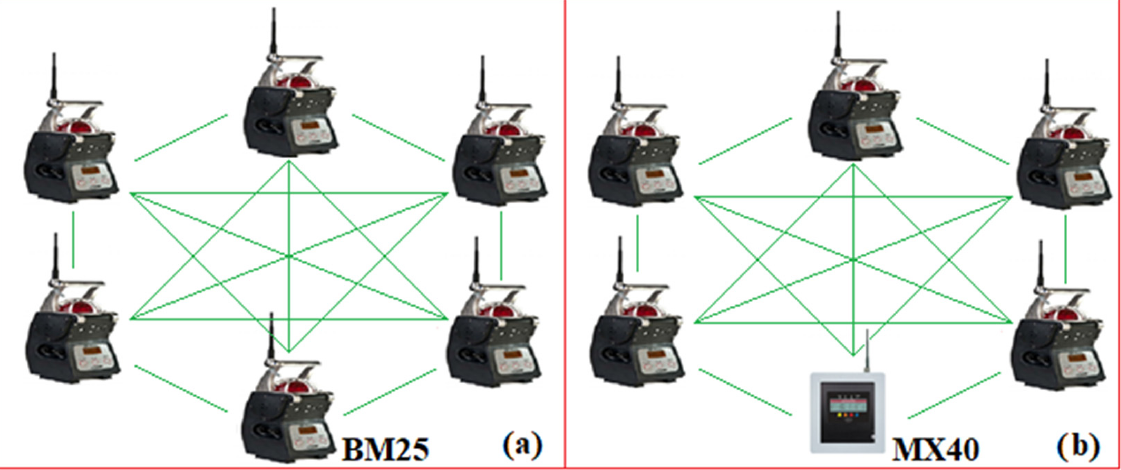
Figure 3. A mesh network ( a ) with six BM25 devices ( b ) with six BM25 devices and a MX40 PLC.